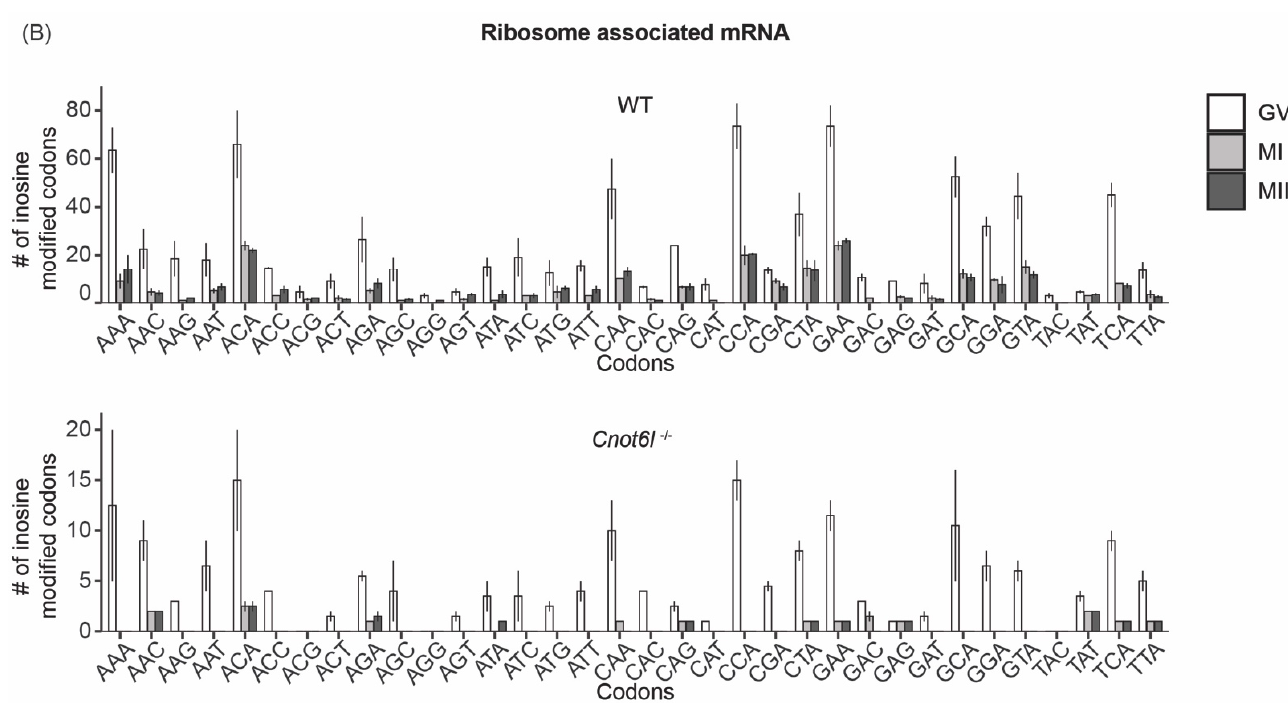
Figure 4. Inosines RNA modifications occur at specific codons. ( A , B ) Number of inosine RNA modifications in adenosine- containing codons in WT, Cnot6l -/- , and Btg4 -/- oocytes, eggs, and zygotes in total RNA. Only codons from transcripts with TPM ≥ 1 were analyzed.